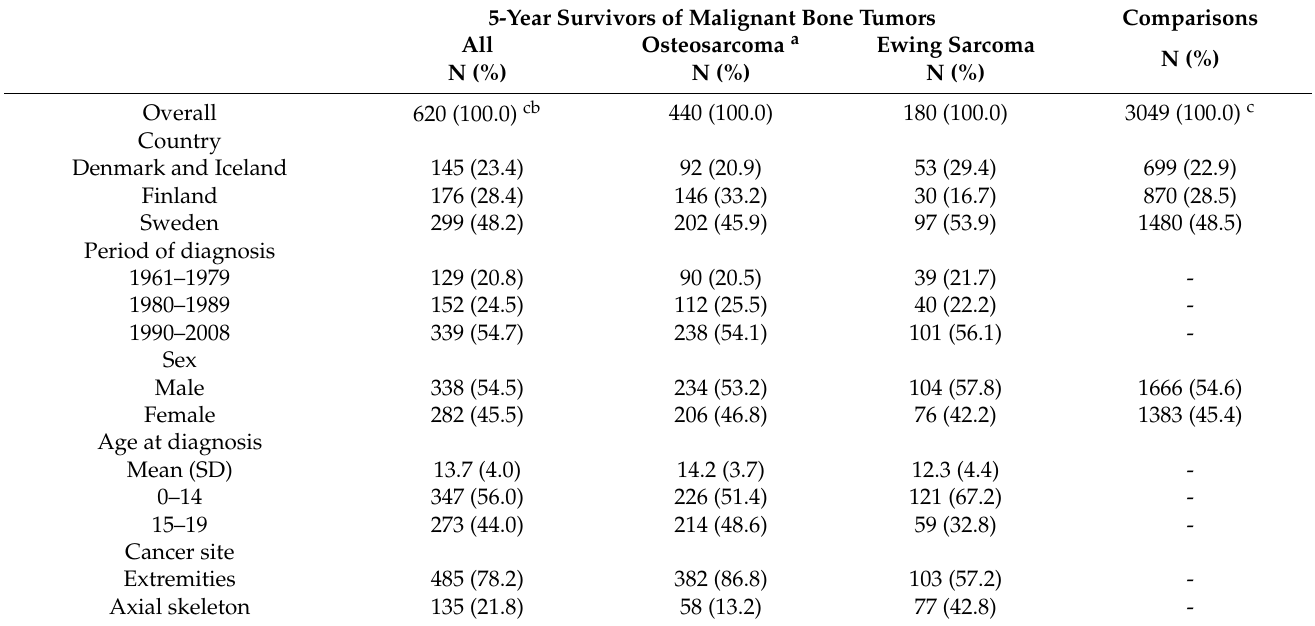
Table 1. Characteristics of the cohort of malignant bone tumor survivors overall, of the sub-cohorts of osteosarcoma and Ewing sarcoma, and of the matched comparison